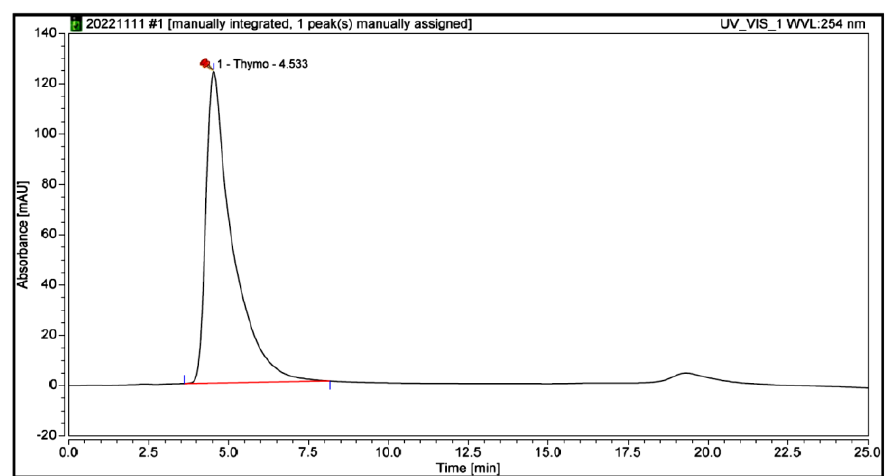
Figure 6. High-performance liquid chromatogram of standard thymoquinone solution.